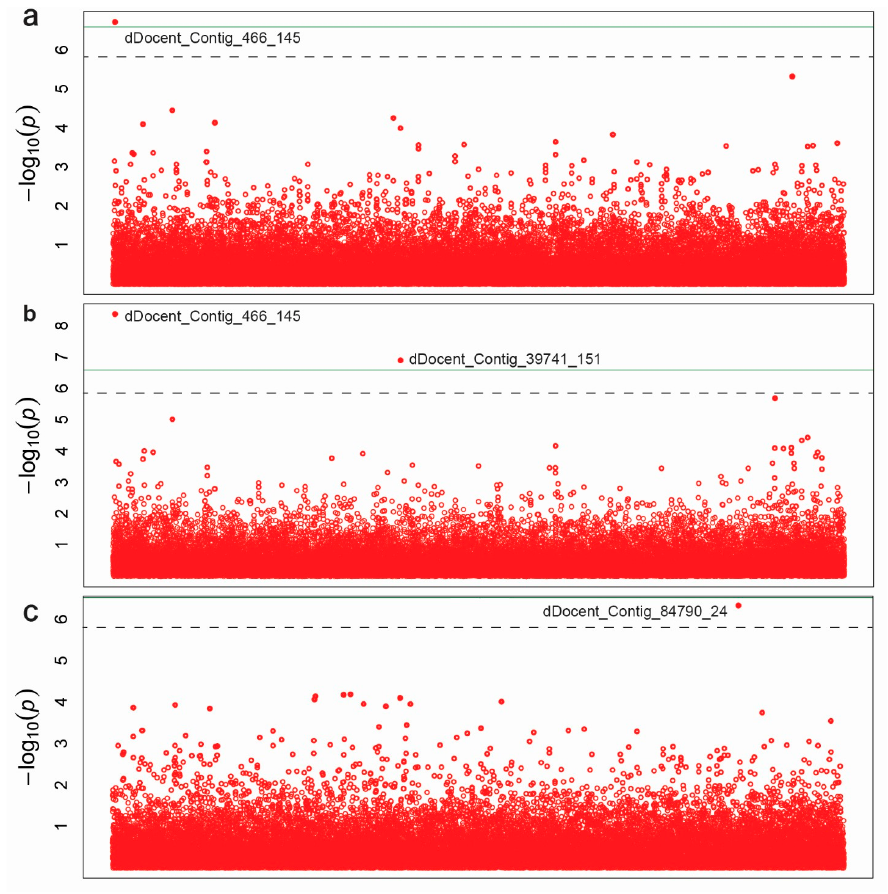
Figure 4. Manhattan plots representing association mapping for the 112 fenugreek genotypes using 38,142 SNPs of seed length ( a ), width ( b ), and color ( c ) arranged in random order (x-axis). The green horizontal solid line represents Bonferroni correction threshold at 6.5. The dashed gray line represents false discovery rate at 5.9.